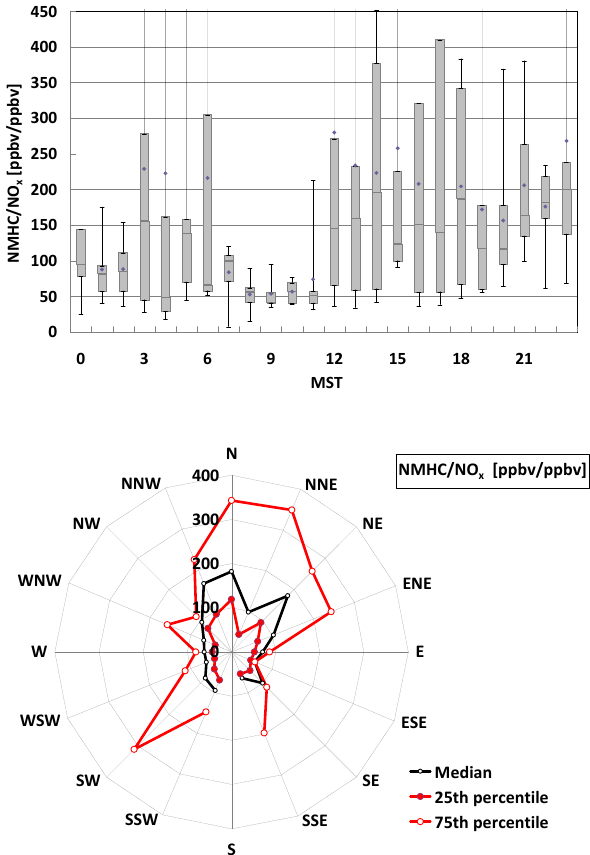
Figure 10. Diurnal variation of fractions of propene equivalent on IOP days. Top: NMHC classes and CH 4 only. Bottom: same as above, but in addition NO x , CO, HCHO, and HONO. Speciated NMHC, NO x , and CO data from the Boulder South Road